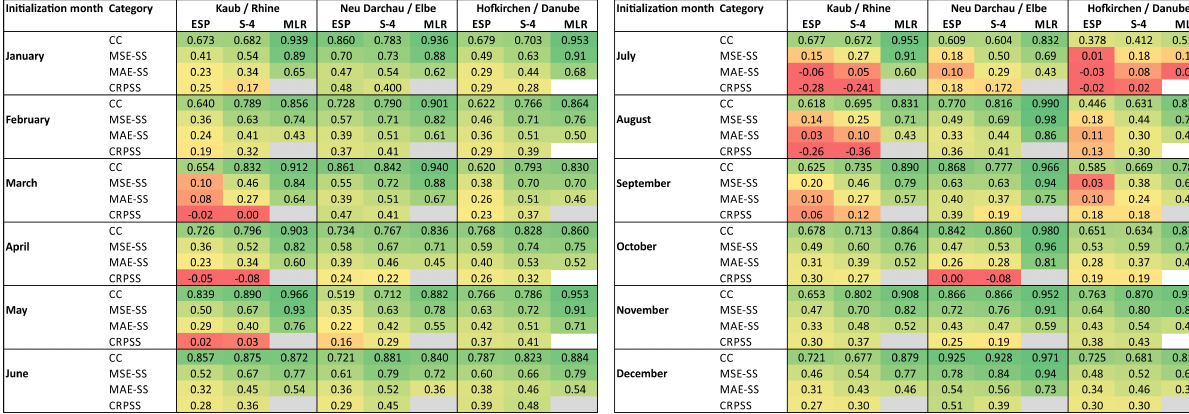
Figure 7. Comparison of monthly forecast skill of ESP, S4-driven and statistical forecasts at the stations Kaub, Neu Darchau, Hofkirchen predicting lowest 7-day mean flow MoNM 7 Q of the current month (verification period 1981–2014).